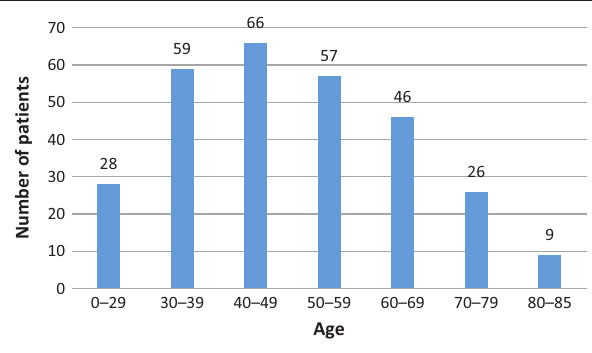
FIGURE 1: Age distribution of the patients in the study ( N =